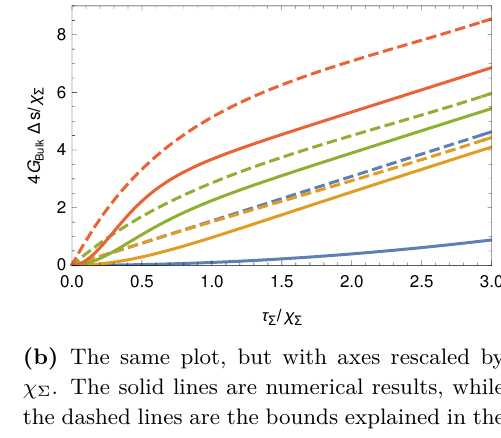
(b) The same plot, but with axes rescaled by χ Σ . The solid lines are numerical results, while the dashed lines are the bounds explained in the main text.